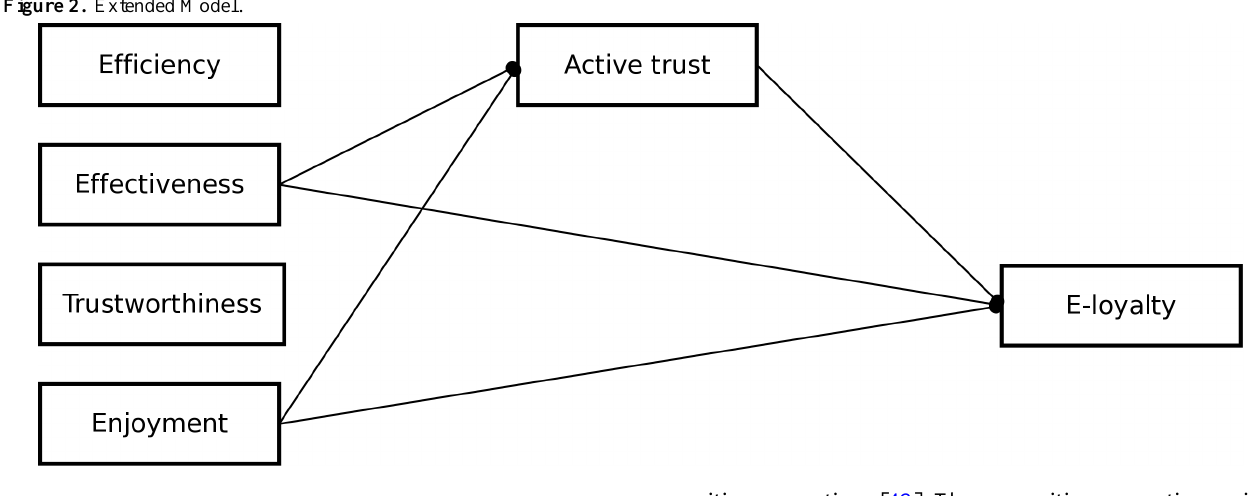
Figure 2. Extended